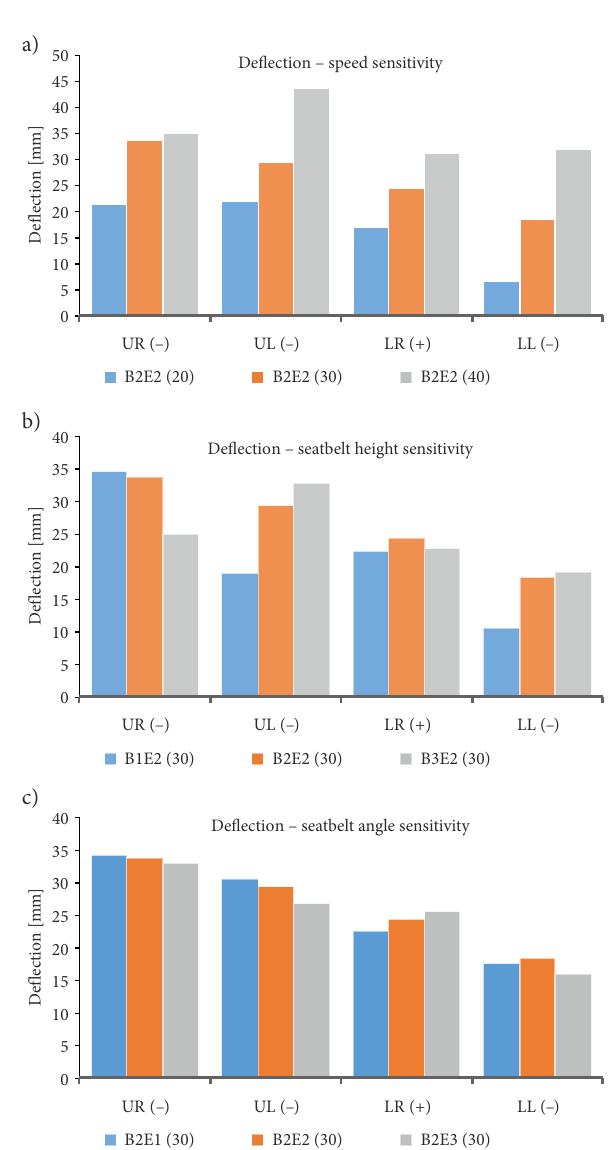
Figure 5. Peak chest deflection sensitivity with study parameters of impact speed (a), seatbelt position (b) and seatbelt angle (c): “+” – extension; “–” –